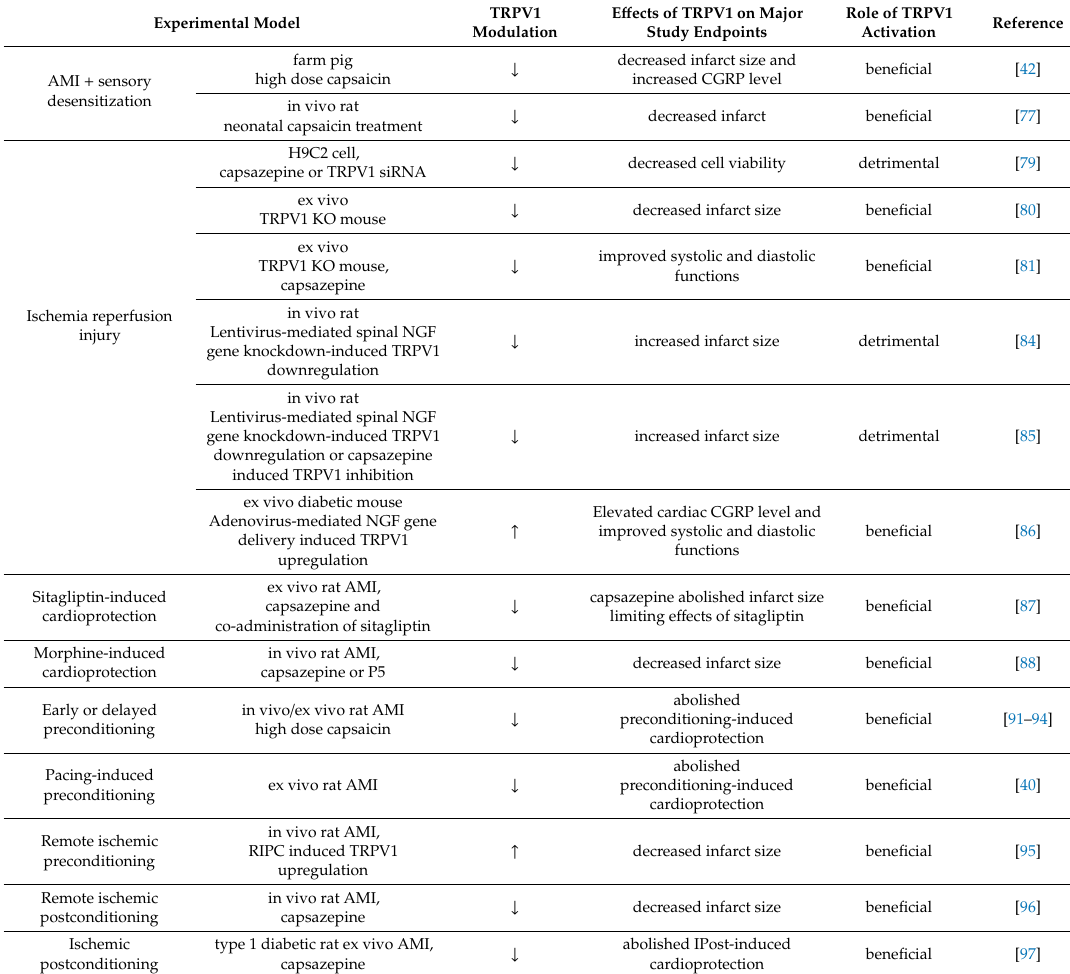
Table 2. Role of the capsaicin-sensitive peptidergic nerves and the TRPV1 channel in I / R injury, AMI, and cardiac ischemic